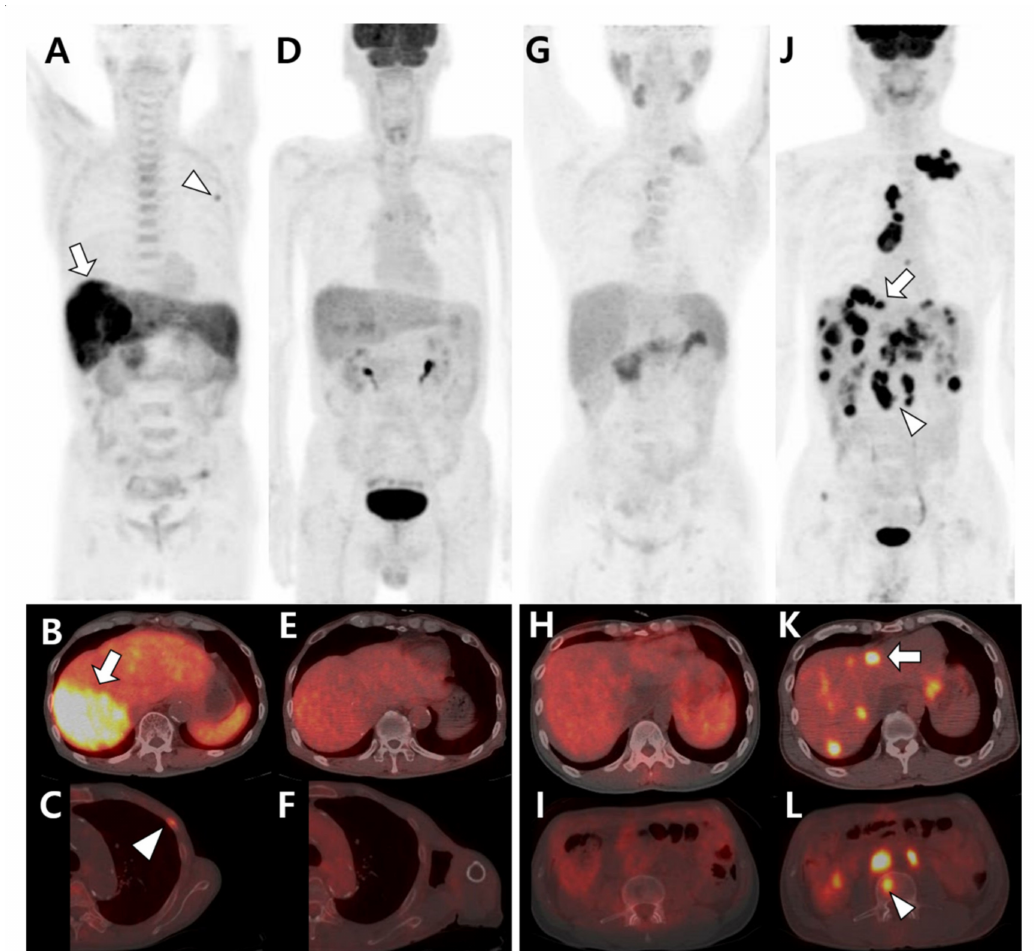
Figure 2. Different tracer avidities of primary and metastatic sites in patients with hepatocellular carcinoma (HCC). ( A – F ) A 77-year-old male patient with well-differentiated HCC. 11 C-acetate positron emission tomography (PET)/computed tomography (CT) ( A – C ) shows high acetate uptake in a primary hepatic tumor (arrow in A , B ) and metastatic bone lesion in the left third rib (arrowhead in A , C ). However, 18 F-fluorodeoxyglucose ( 18 F-FDG) PET/CT ( D – F ) shows no significant uptake in the related sites. ( G – L ) A 43-year-old male patient with poorly differentiated HCC. 11 C-acetate PET/CT ( G – I ) shows mild uptake or isometabolism in the hepatic tumor ( H ) and metastatic bone lesion ( I ). In contrast, 18 F-FDG PET/CT ( J – L ) shows intense FDG uptake in hepatic tumors (arrow in J , K ) and multiple metastatic lesions in the lymph nodes and bones (arrowhead in J , L